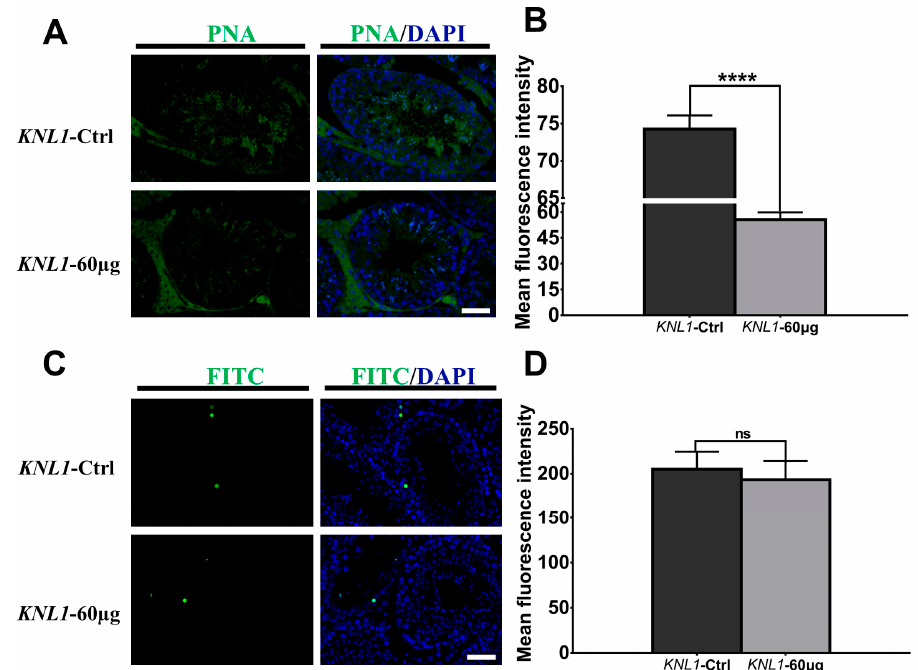
Figure 5. Effects of loss-function of KNL1 on acrosome and apoptosis. ( A ) The PNA immunofluorescence of a section of the testicle. Testis was immunostained with anti-PNA (green). Merge was DAPI (blue) and PNA (green). The top is KNL1 -Ctrl mice and the bottom is KNL1 -60 µ g mice. Bar = 50 µ m. ( B ) Mean immunofluorescence intensity of PNA between KNL1 -Ctrl mice and KNL1 -60 µ g mice. ( C ) The TUNEL assay of a section of the testicle. The FITC immunofluorescence of a section of the testicle. Testis was immunostained with anti-FITC (green). Merge was DAPI (blue) and FITC (green). The top is KNL1 -Ctrl mice and the bottom is KNL1 -60 µg mice. Bar = 50 µm. ( D ) Mean immunofluorescence intensity of TUNEL between KNL1 -Ctrl mice and KNL1 -60 µg mice. All data were at least measured by three independent experiments. Asterisk denotes statistical difference level of significance (****, p < 0.0001, ns > 0.05).